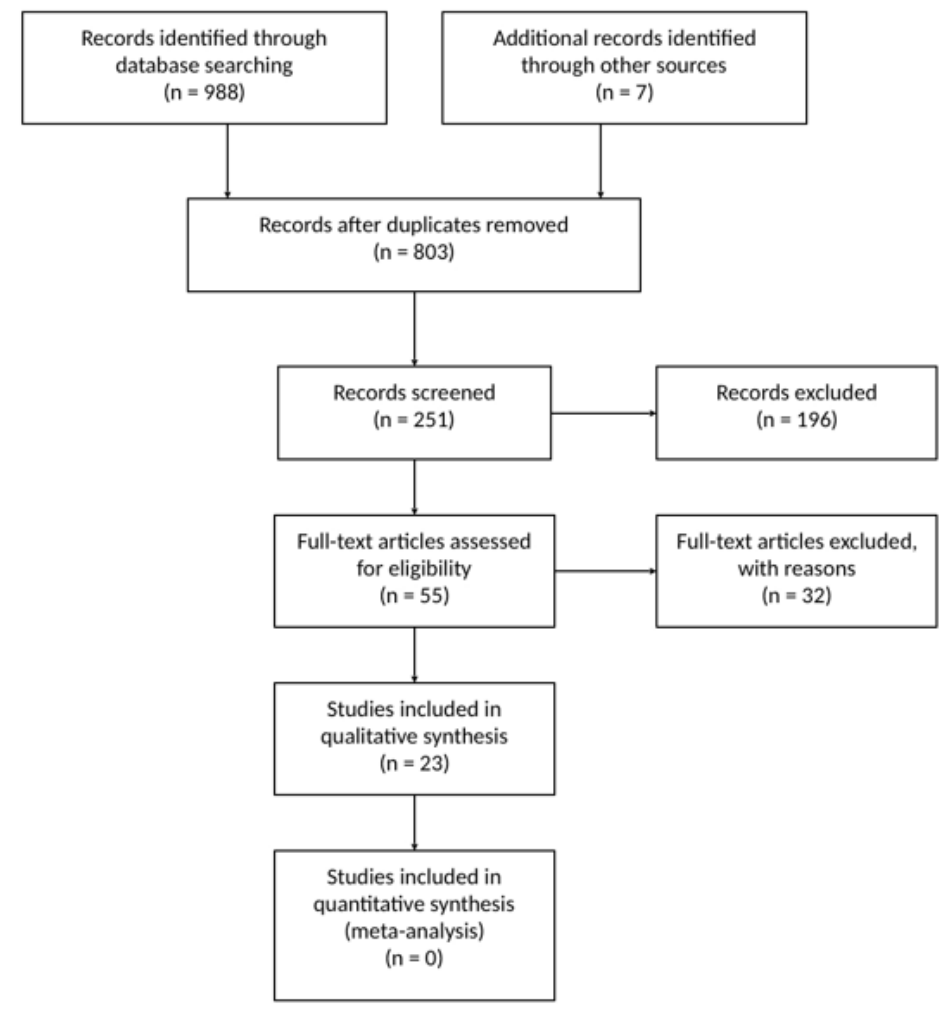
Figure 1. Flow chart of the systematic review.